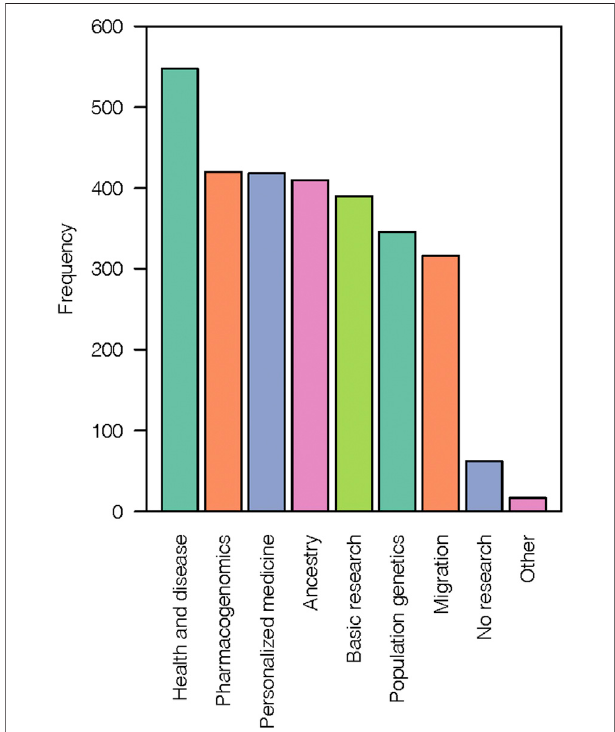
FIGURE 2 | Types of genetic research that should be allowable on the Navajo Nation. The bar plot shows the frequency of respondent ’ s answers for each provided research category. Respondents were allowed to choose multiple answers for this question. The “ Other ” category included write- in responses like human microbiome, nutrigenetics, longevity, clan characteristics, and cancer.